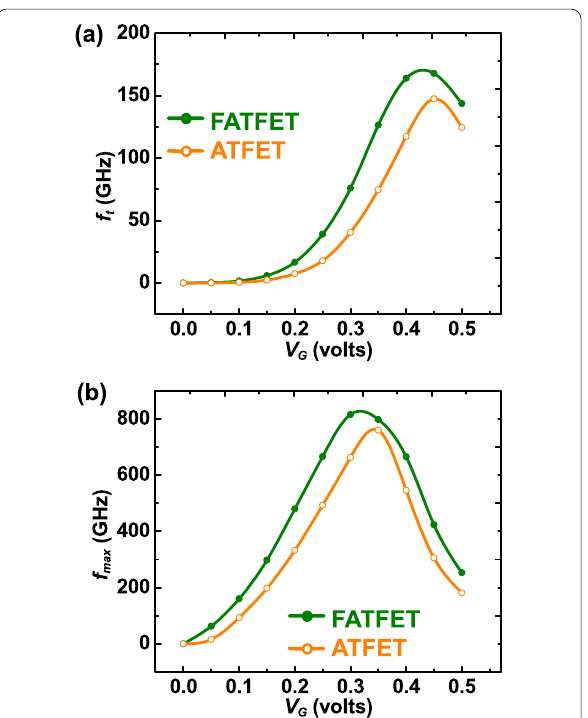
Fig. 8 RF comparison of FATFET and ATFET in terms of a f t and b f max . The benefit of ≈ 0.1 V can be achieved from FATFET at the targeted maximum frequency range of